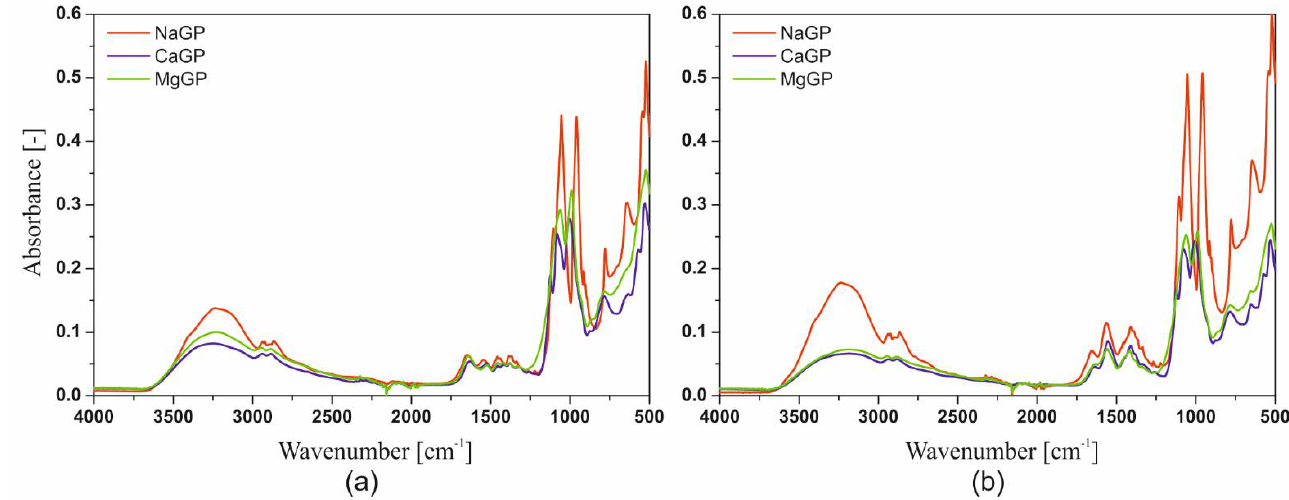
Figure 12. Fourier Transform Infrared Spectroscopy (FTIR) spectra obtained for chitosan chlorides ( a ) and acetates ( b ) with the addition of disodium glycerophosphate (red), calcium glycerophosphate (blue), or magnesium glycerophosphate (green).